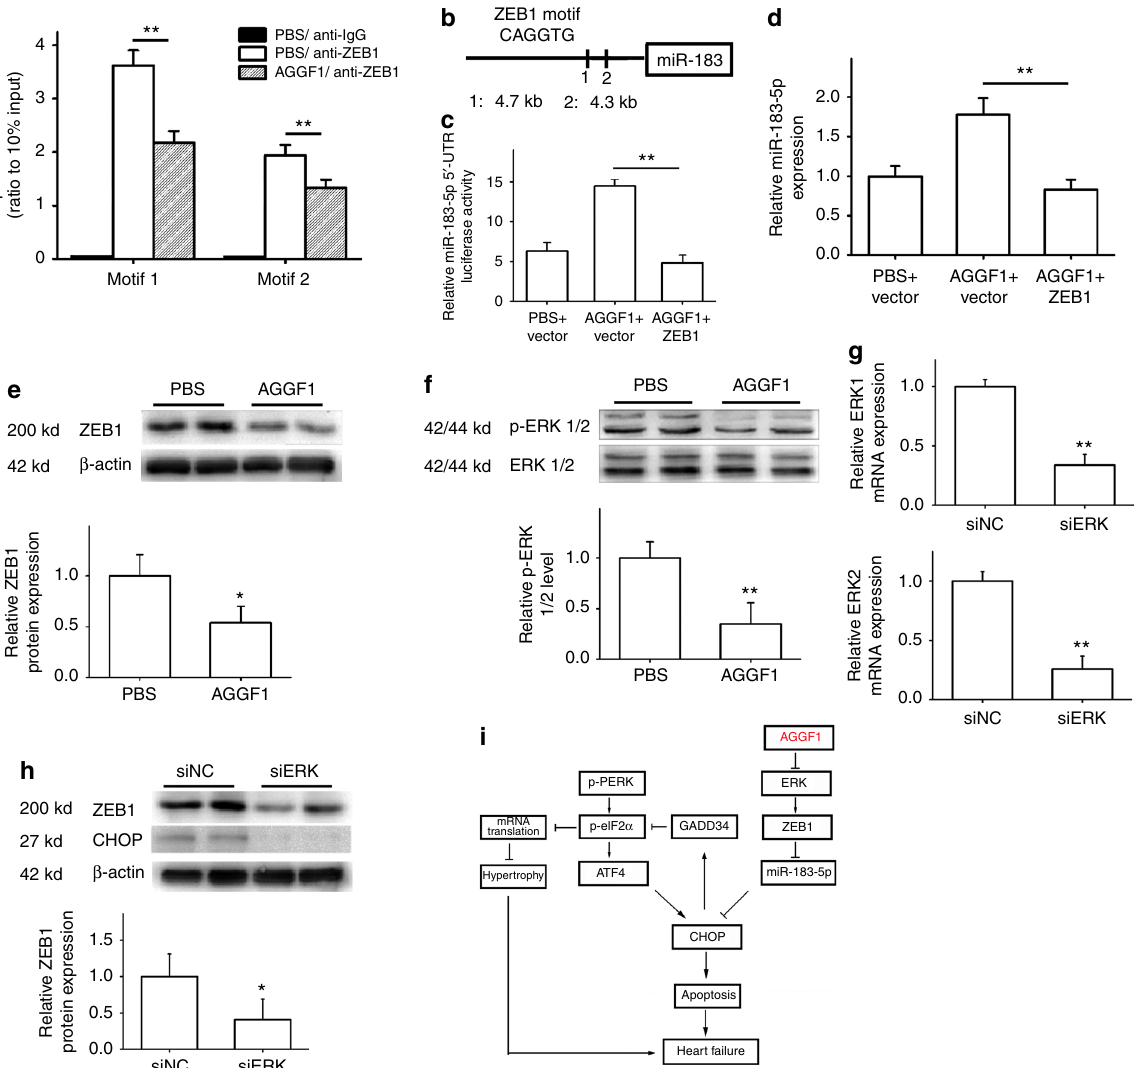
Fig. 6 Mechanism for AGGF1 regulation of miR-183-5p expression. a ChIP – qPCR analysis for the interaction between ZEB1 and miR-183-5p promoter DNA ( n = 4/group, ** P < 0.01). b Schematic diagram showing that the miR-183-5p promoter-luciferase reporter with two ZEB1-binding motifs. c Luciferase activity ( n = 6/group, ** P < 0.01). d Real-time RT-PCR analysis for miR-183-5p expression in H9C2 cells after AGGF1 treatment with or without ZEB1 overexpression ( n = 3/group, ** P < 0.01). e Western blot analysis for the ZEB1 level in H9C2 cells after AGGF1 treatment ( n = 5/group, * P < 0.05). f Western blot analysis for activation of ERK1/2 in H9C2 cells after AGGF1 treatment ( n = 5/group, ** P < 0.01). g Real-time RT-PCR analysis for ERK1 and ERK2 expression by ERK siRNA ( n = 3/group, ** P < 0.01). h Western blot analysis for the ZEB1 level by ERK siRNA ( n = 5/group, * P < 0.05). i Schematic model for a non-canonical ER stress signaling pathway mediated by AGGF1. Data are shown as the mean ± s.d. from at least three independent experiments. Statistical analysis was carried out by a Student ’ s two-tailed t